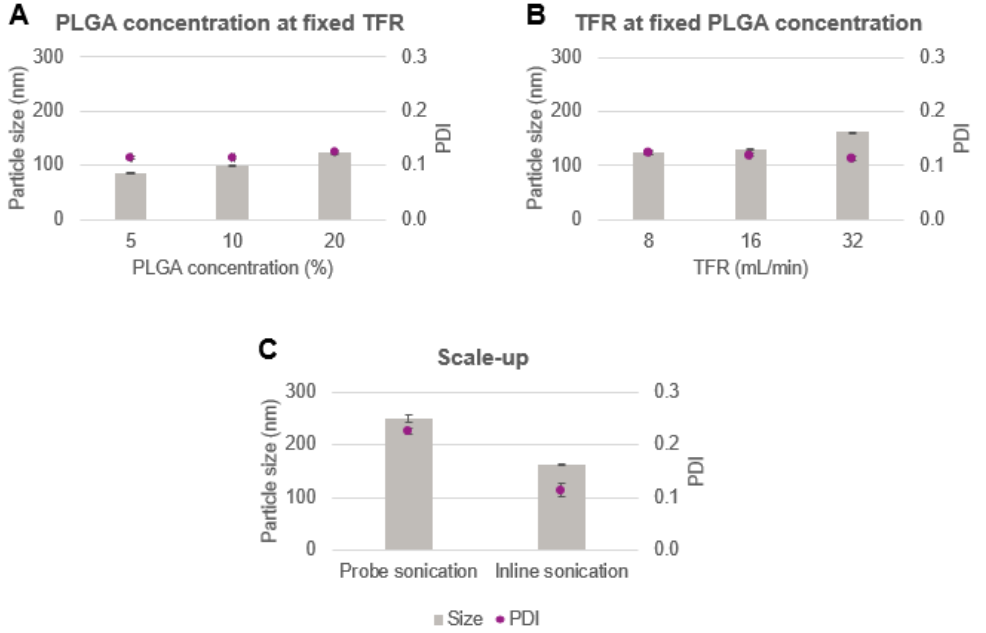
Figure 7. Scale-up of nanoformulations. ( A ) Size and PDI of the particles obtained at varied PLGA concentrations and fixed total flow rate of 8 mL/min. ( B ) Particle size and size distribution of placebo particles obtained applying different TFRs by using an initial PLGA concentration of 20 wt% in EtOAc. ( C ) Comparison of the particles obtained with the scaled-up indirect inline technology versus particles achieved at a higher processed volume and lower total sonication time of direct probe batch